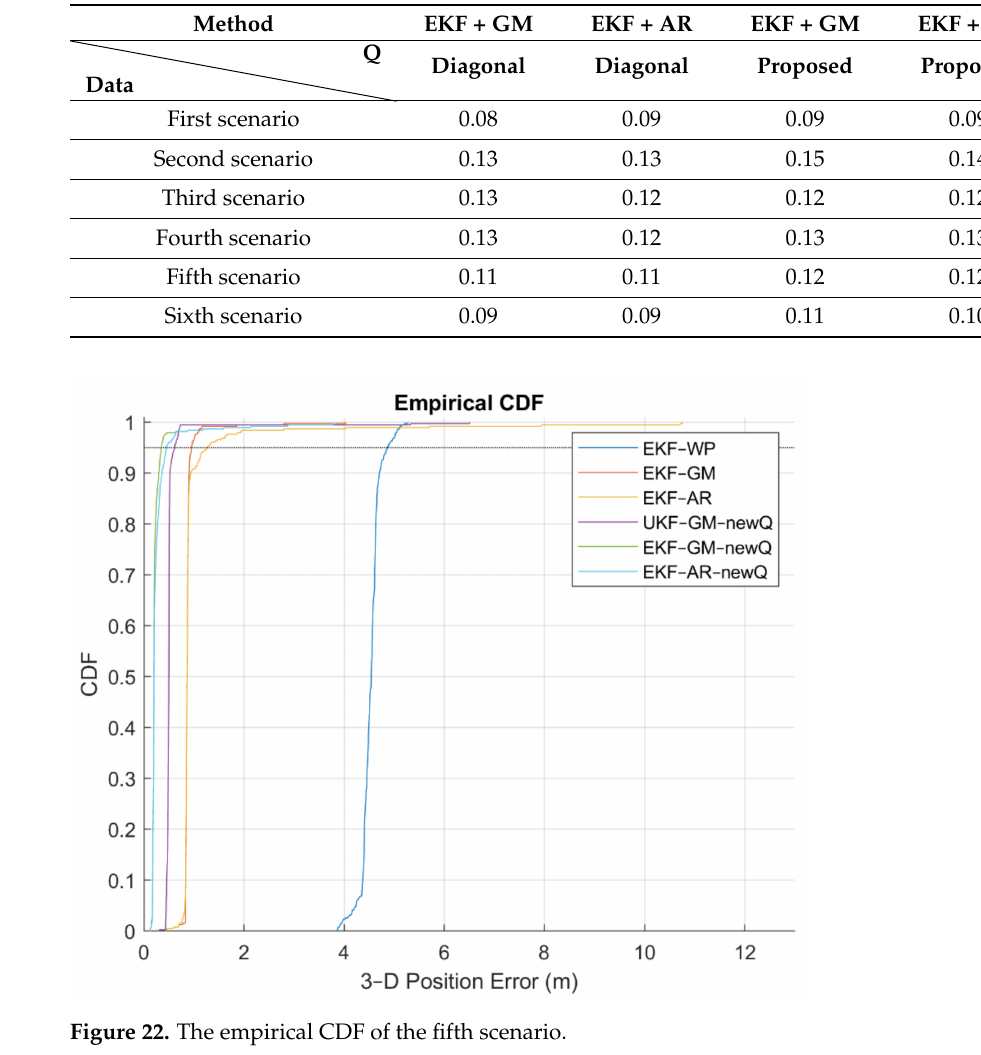
Table 3. The CPU time of EKF algorithm to determine the position of a point with and without the proposed VCM [ms].